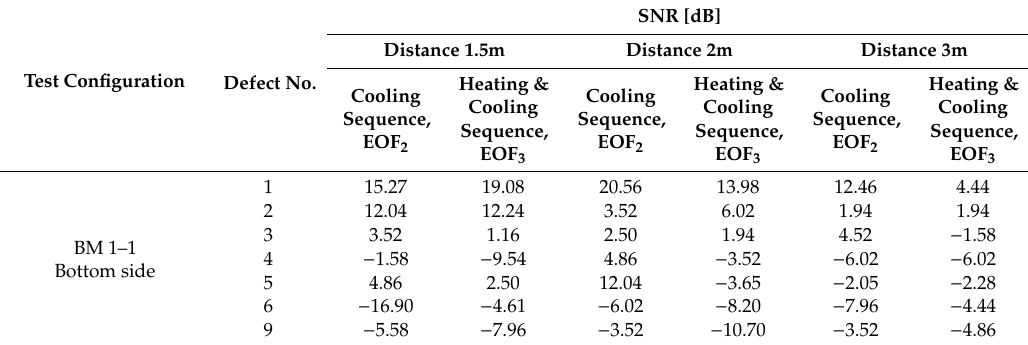
Table 8. SNR values obtained from images presented in Figure 13.